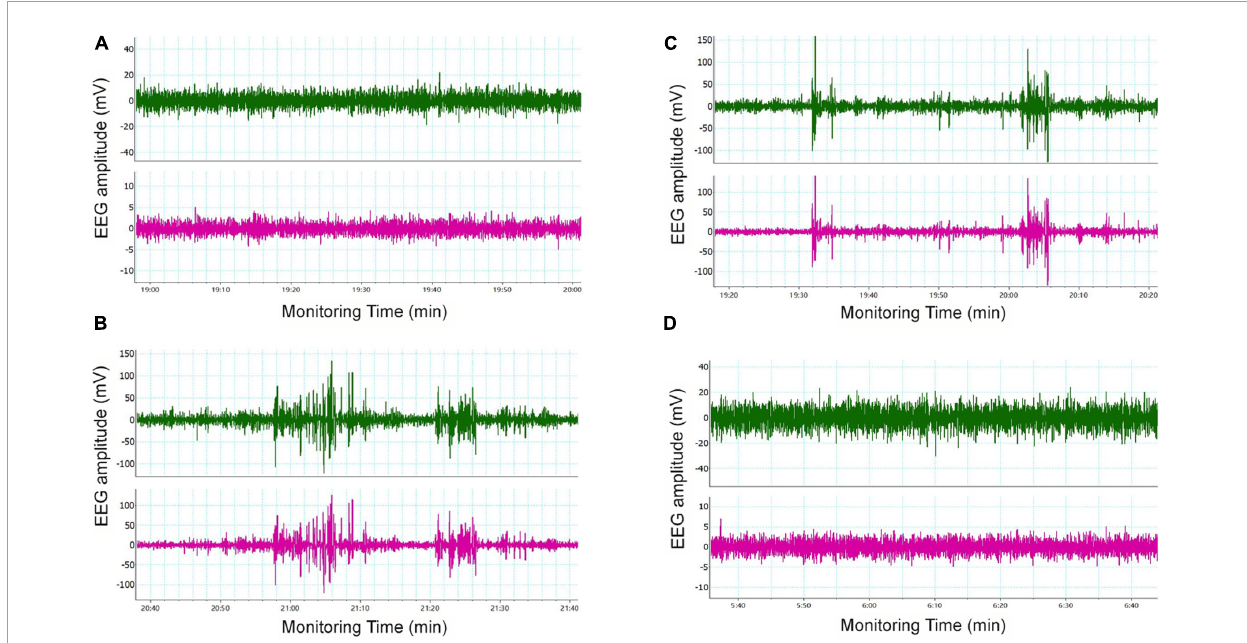
FIGURE3 Typical cortical EEG in mice. Mice were subjected to in vivo EEG detection and cortical EEG signals were collected. Green is frontal lobe electrode, red is parietal lobe electrode, and blue is neck EMG. (A) WT group, (B) LoF group, (C) LoF + EFV group, and (D) WT + EFVgroup.